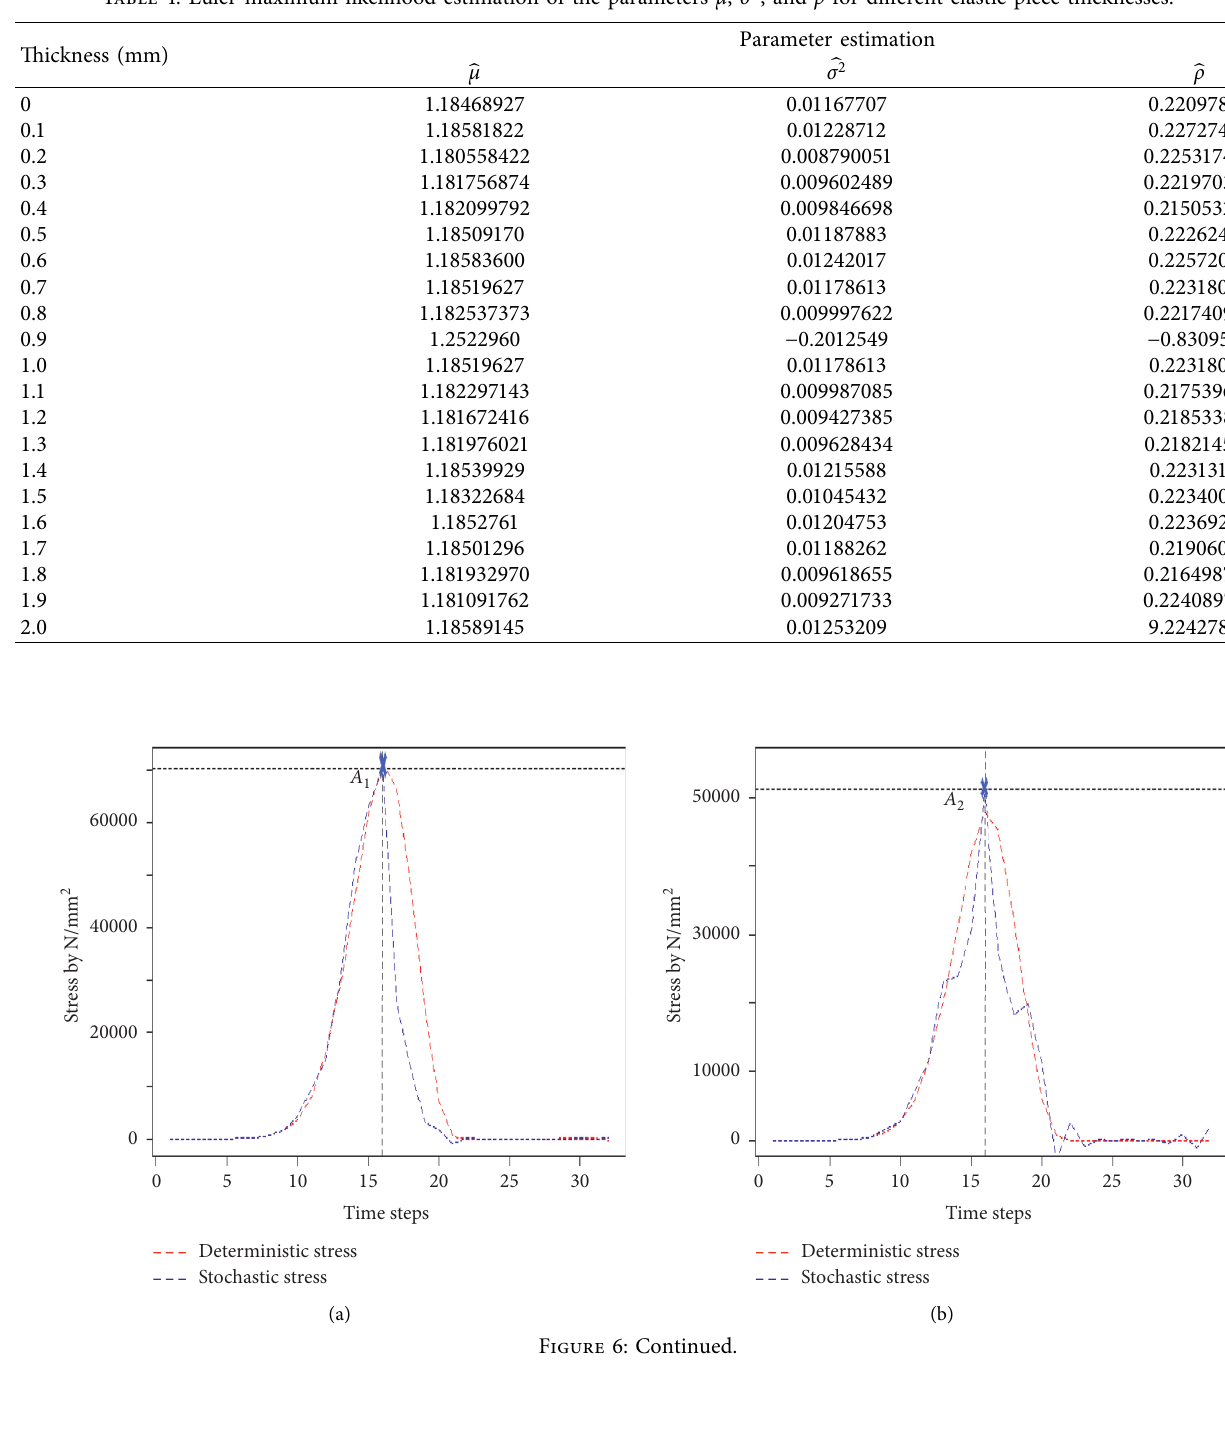
Table 4: Euler-maximum likelihood estimation of the parameters μ , σ 2 , and ρ for different elastic piece